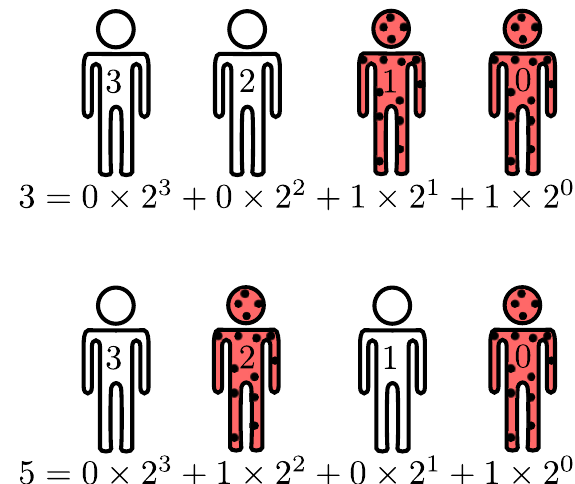
Figure 5. Agent configurations using binary representation for µ = 3 and 5 with N = 4. For | µ = 3 (cid:105) = | 0011 (cid:105) , whereas | µ = 5 (cid:105) = | 0101 (cid:105) . In both configurations, two agents are infected (red